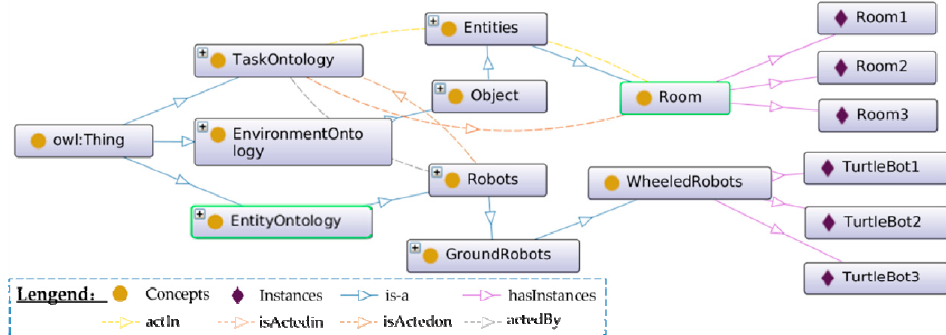
Figure 6. The relationships among three parts in Protégé.